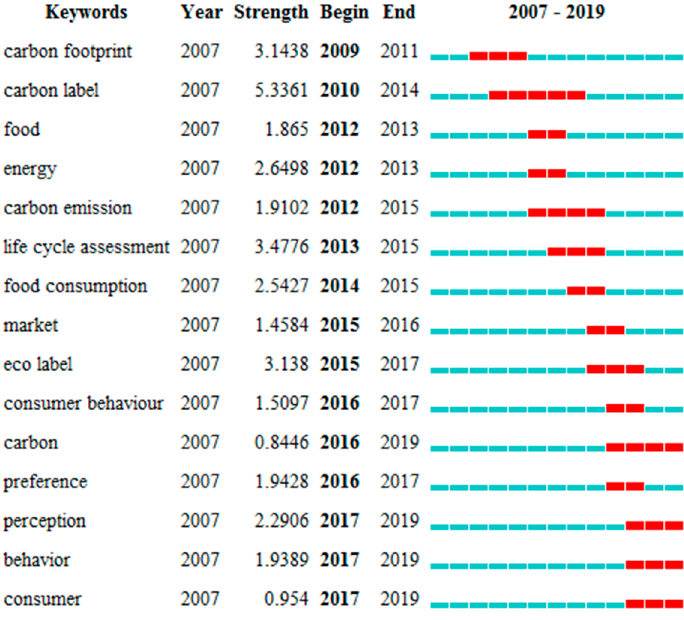
Figure 7. Top 15 Keywords ranked by burst detection.